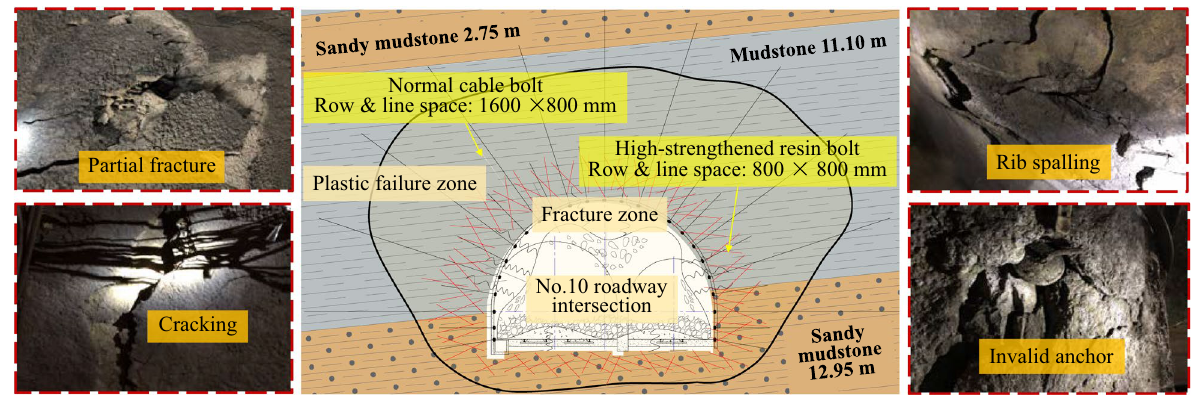
Fig. 7 Schematic of original support scheme and roadway breakdown and deformation